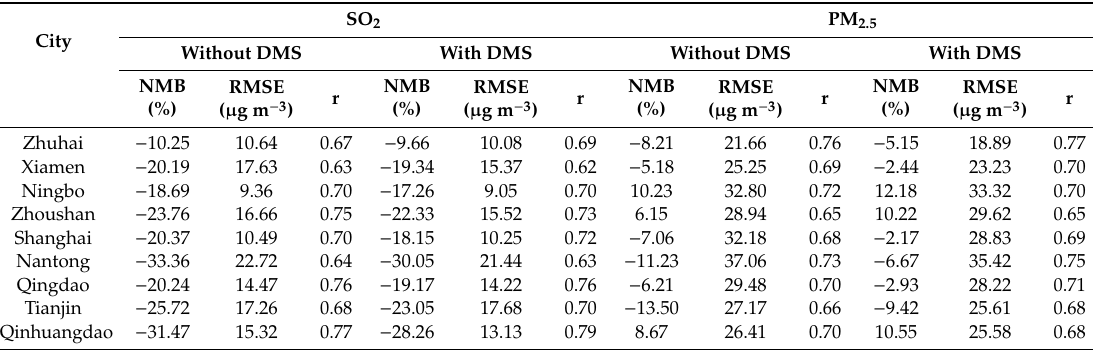
Table 1. Statistical metrics of SO 2 and PM 2.5 with and without DMS in nine eastern coastal cities of China in